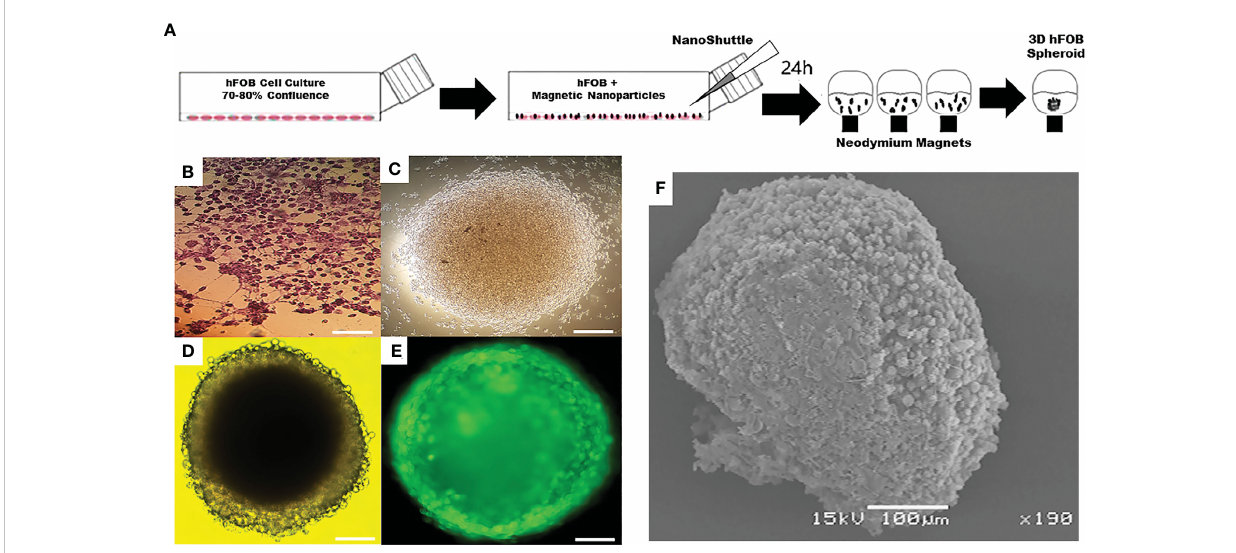
FIGURE 2 Application of magnetic levitation system in organoids. (A) Schematic of magnetic levitation technique. A con fl uent fl ask of hFOB cells was incubated with NanoShuttle overnight to allow for cell membrane-binding of the magnetic nanoparticles. The next day, the cells were seeded onto 96-well plate placed atop a magnetic drive of 96 neodymium magnets, the magnetic fi eld in fl uencing the hFOB cells to form an air-liquid interface and guide them to aggregate within hours of levitation to form the 3D Spheroid. (B) Optical micrograph of 2D tissue culture plate. (C) 3D hFOB spheroid after 3 h of magnetic levitation culture. (D) 3D hFOB spheroid after 24 h of magnetic levitation culture. (E) Fluorescence micrograph of 3D hFOB spheroid after 24 h of magnetic levitation culture. (F) Morphology of the 3D hFOB spheroid obtained by SEM with the presence of osteogenic factors incubated for 14 days under magnetic levitation system. FOB: fetal osteoblasts. Adapted with permission from (51), copyright 2021, Frontiers Media